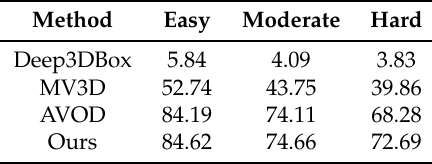
Table 3. Average Orientation Similarity (AOS) (in %) at 0.7 3D IoU.